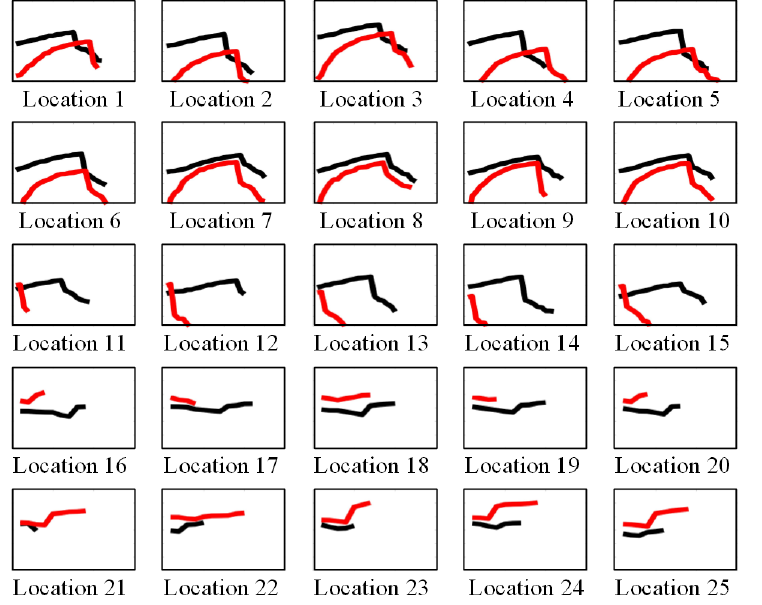
Figure 6. Extracted CSI amplitude